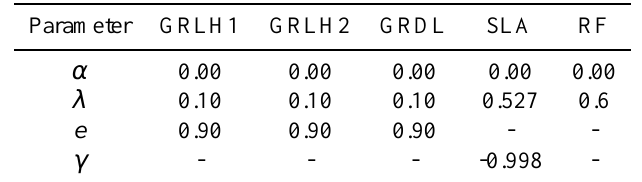
Table 6. Parameter values used for comparing the greedy pro- cedures.